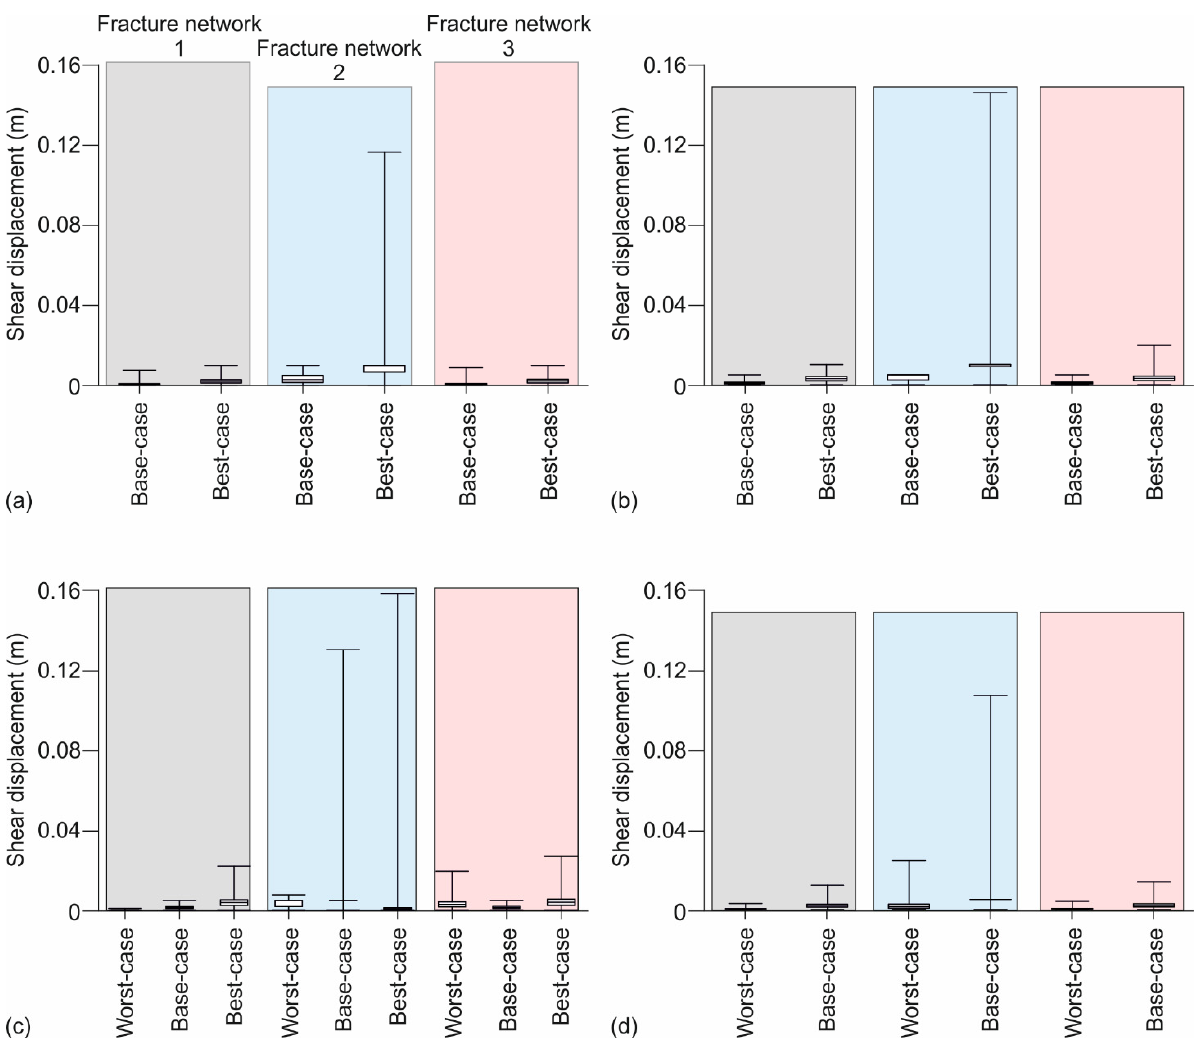
Figure 9. Boxplot of fracture shear displacement with whiskers from minimum to maximum: ( a ) stimulation pressure of 20 MPa; ( b ) stimulation pressure of 30 MPa; ( c ) stimulation pressure of 40 MPa; ( d ) stimulation pressure of 50 MPa. The reader is referred to Section 4.2 for further details on the fracture network and to Table 1 for further information on the properties of the medium.